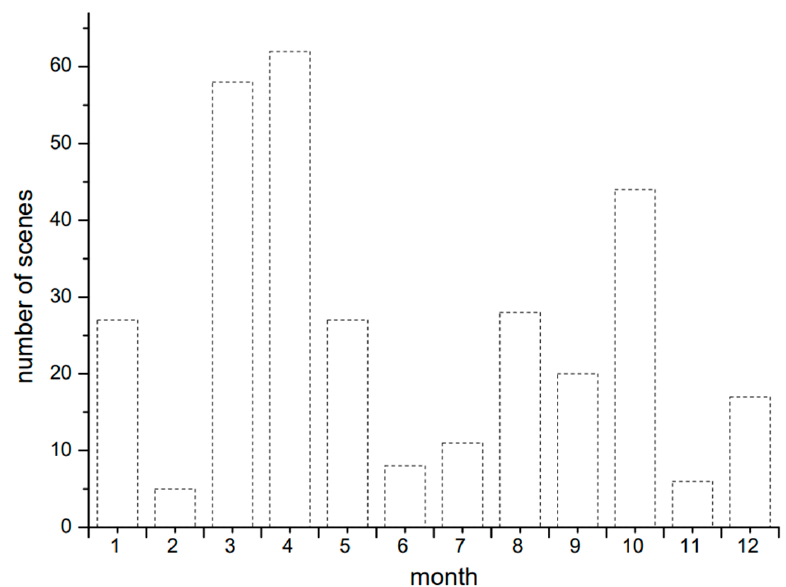
Figure 6. Statistics of 313 GF-2 scenes distributing in each month.